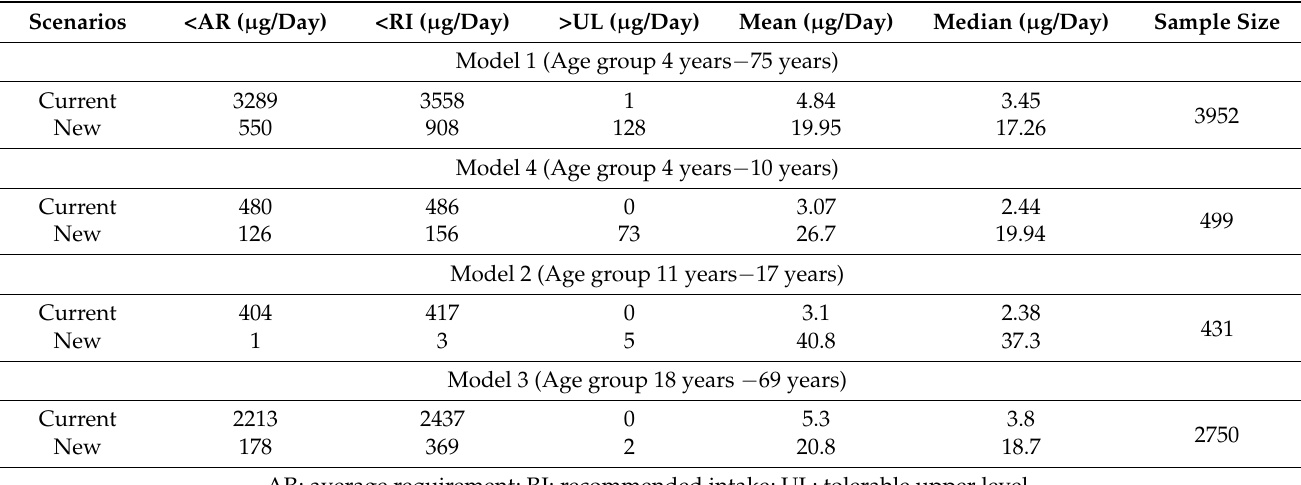
Table 5. Comparison of the vitamin D exposure levels between the current scenario and the new scenario (after optimal fortification). Three thresholds (AR, RI, and UL) are used as references, and the number of people below the AR and RI and above the UL are reported for both scenarios, along with the total sample size for that age group. Mean and median estimated daily vitamin D intake is reported in µ g/day.